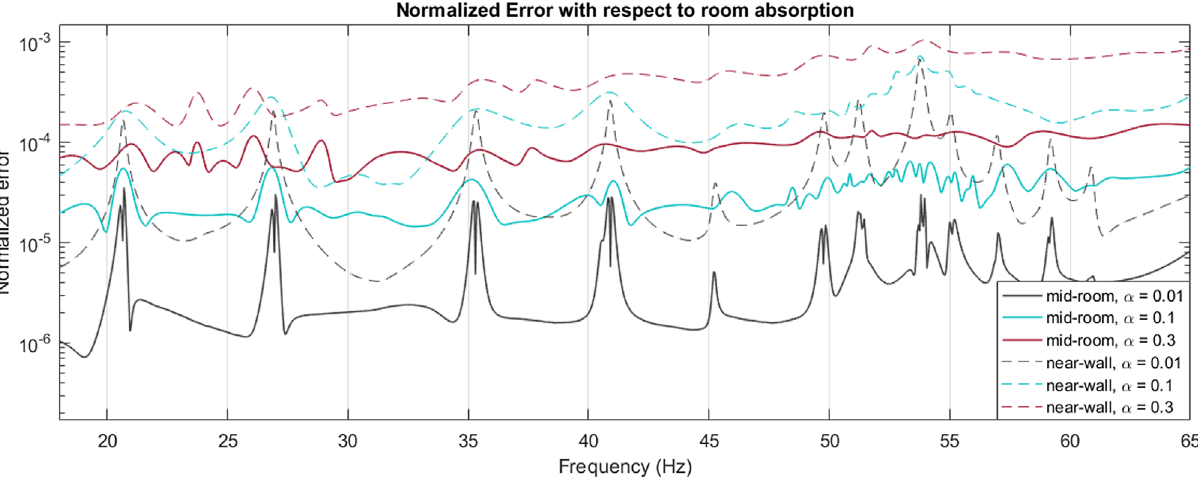
Figure 8. Comparison of the normalized error between different cases of room absorption for the reconstruction of the rectangular volume and a plane near a wall of the